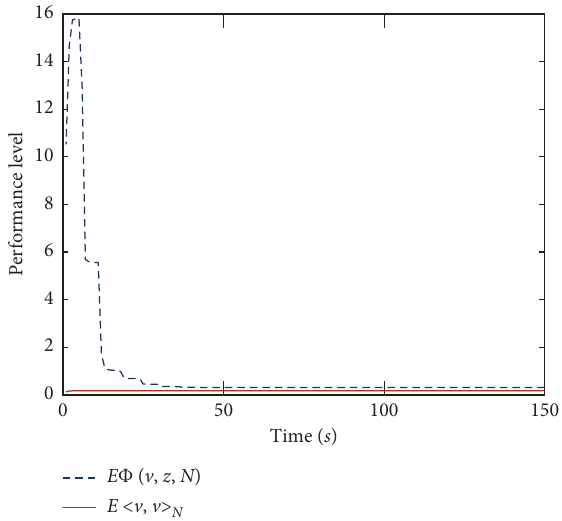
Figure 3: The trajectories of performance level E Φ ( v, z,N ){ } and E 〈 v, v 〉 N of closed-loop DTNSNSs (5) with time delay.